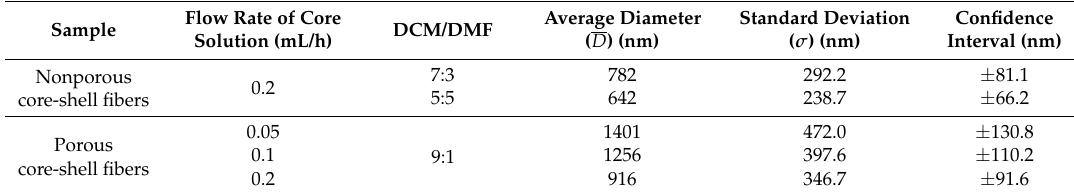
Table 1. Average diameters of TPP loaded core-shell nanofibers.